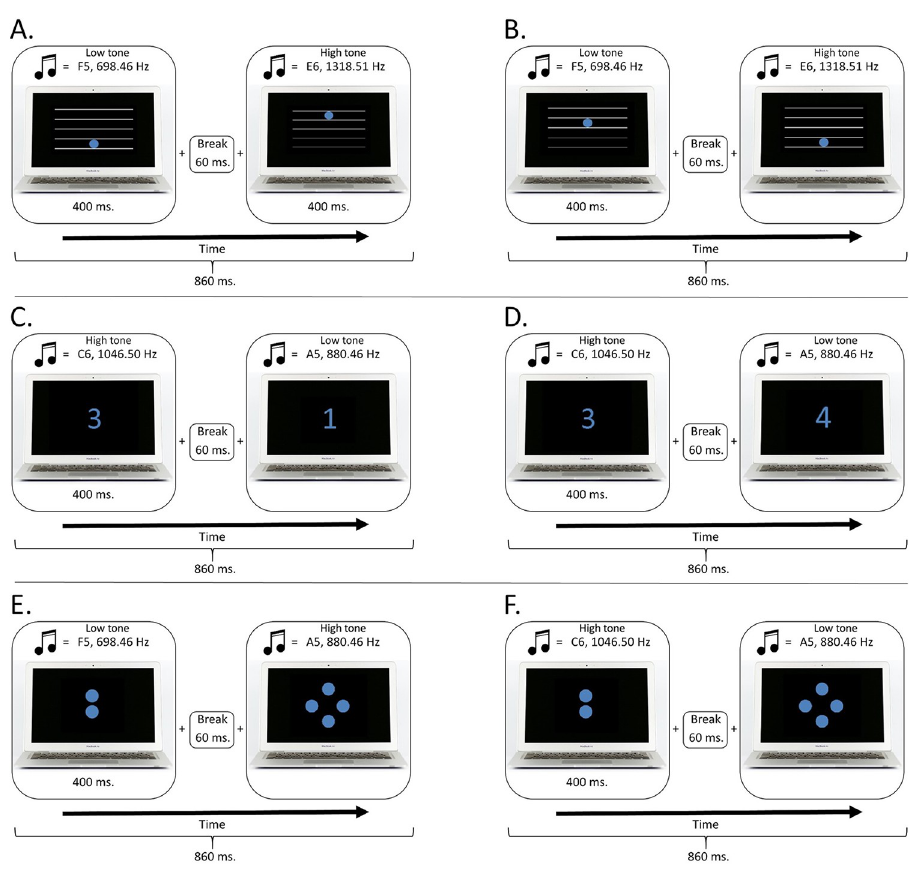
Fig 2. Examples of the experimental procedure in both congruent and incongruent conditions for each of the tree audiovisual stimulus category. Panels A–B illustrate congruent and incongruent trials in the pitch-elevation category, respectively. Each panel/trial consisted of a single video with the total length of 860 ms. In this video clip, the participant saw two visual stimuli each associated with a sound on a particular pitch. The pitch varied in frequency and the visual stimulus varied in elevation. Congruency was estimated according to an explicitly learned rule, “The higher the spatial elevation, the higher the tone”. Panels C–D illustrate congruent and incongruent trials in the symbolic magnitude-pitch category, respectively. Here, the stimulus varied in value of the number shown and congruency was estimated according to the explicitly learned rule, “the higher the number presented, the higher the tone”. Panels E–F illustrate congruent and incongruent trials in the non-symbolic magnitude-pitch category, respectively. Here, the stimulus varied in the number of circles shown and congruency was estimated according to the explicitly learned rule, “the more dots presented, the higher the tone”. Note that in each category congruency/incongruency could be induced either with the visual or with the auditory part of the